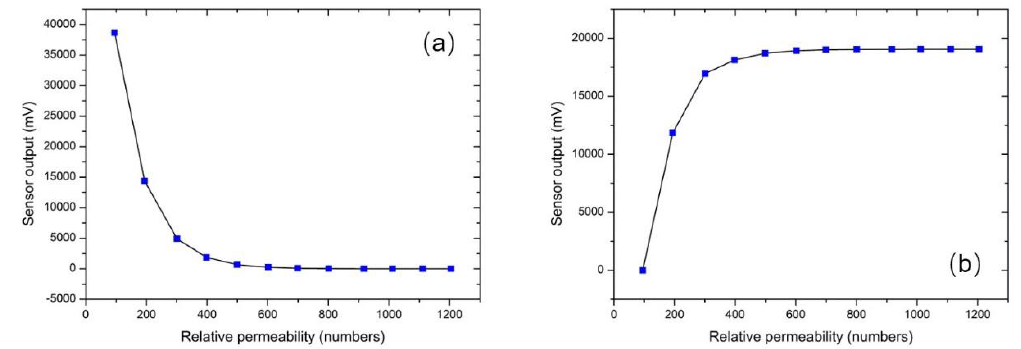
Figure 10. The response of the force sensor based on the MDL technique, for all three samples: ( a ) the